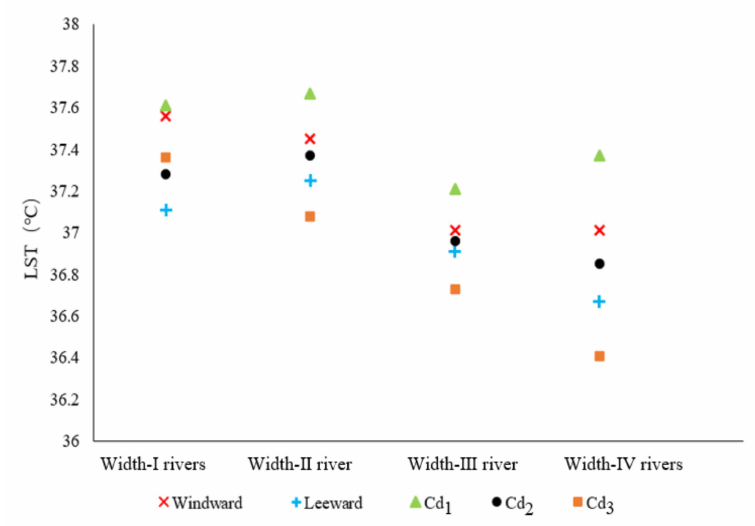
Figure 23. Correlation analysis between LST and LG or Cd factors of different grades of